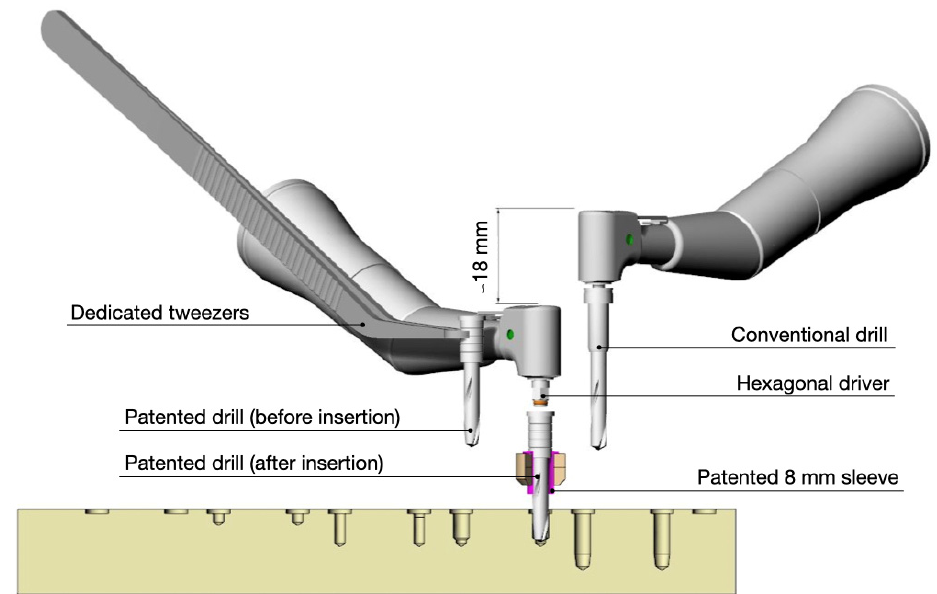
Figure 2. Comparison of the vertical clearance (different by approximately 18 mm) between conventional and patented drills for guided implant surgery. In the scheme, the tips of both drills (left and right drills) are at the level of the edge of the surgical sleeve. After the insertion of the patented drill into the sleeve by means of dedicated tweezers (middle drill), the overall inter-arch space necessary for surgery is reduced by about 18 mm.